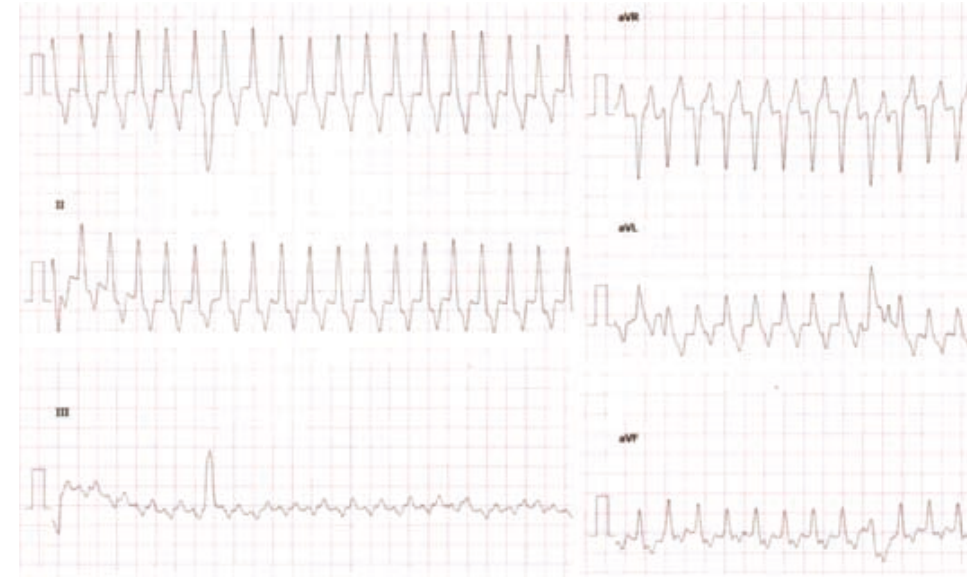
Fig. 8 . E of animal number S7 showing ventricular tachycardia (Heart rate = 214 CG beats per minute) (Paper speed – 25 mm/sec)